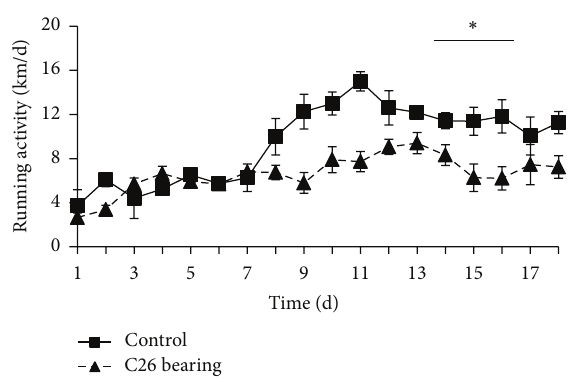
Figure 2: Kinetics of physical activity in healthy and C26-bearing BALB/c AnNCrl mice. Seven-week-old female BALB/c AnNCrl mice were individually placed in wheel equipped cages. At the same time a group (C26 bearing) was subcutaneously transplanted with the C26 colon carcinoma to induce muscle wasting. The running distance was daily recorded and averaged among replicates from at least three independent experiments. Both healthy and diseased mice do exercise, even though C26-bearing mice run for up to 6 Km/day, while healthy mice increased the daily distance run on the wheel to 11Km/day. ∗ P < 0.01 by Tukey’s HSD test versus C26- bearing